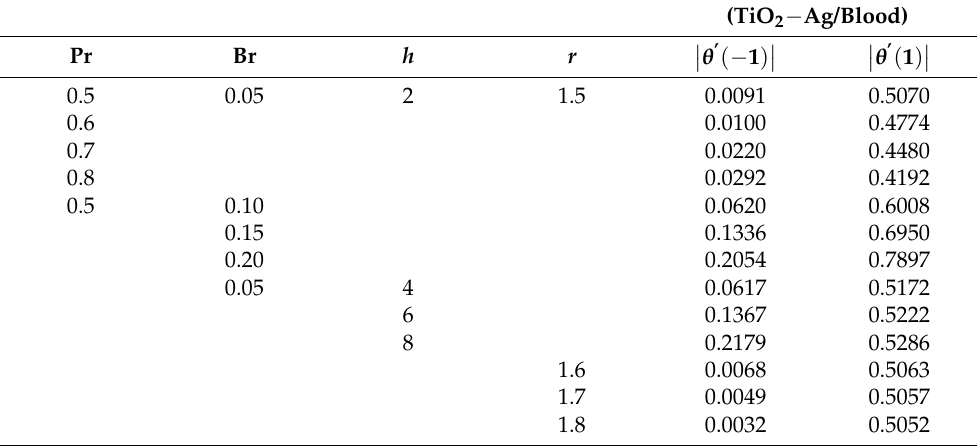
Table 7. Heat transfer result on the Prandtl number, Brickman number, Nano-layer thickness, and the radius of particle for M = 9, ϕ 1 = ϕ 2 = 0.01, α = 1, β = 0.1, Re = − 0.5, Nt = Nb = 0.5 on hybrid nanofluids.